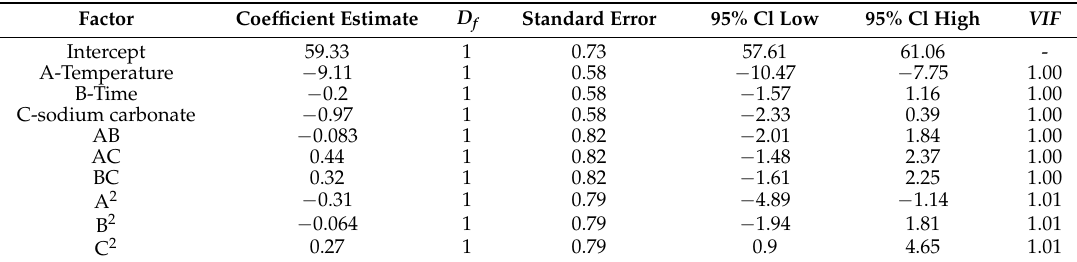
Table 6. Confidence analysis of the quadratic model. VIF: variance inflation factor.